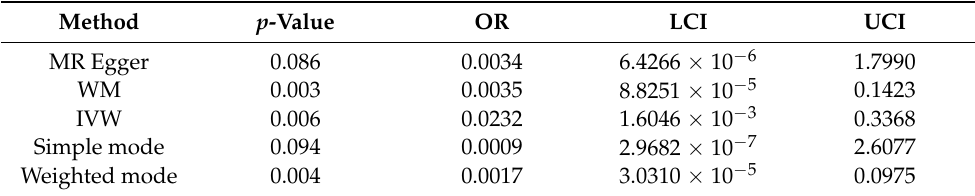
Table 3. MR results of the causal association between metformin treatment and RA using various methods.